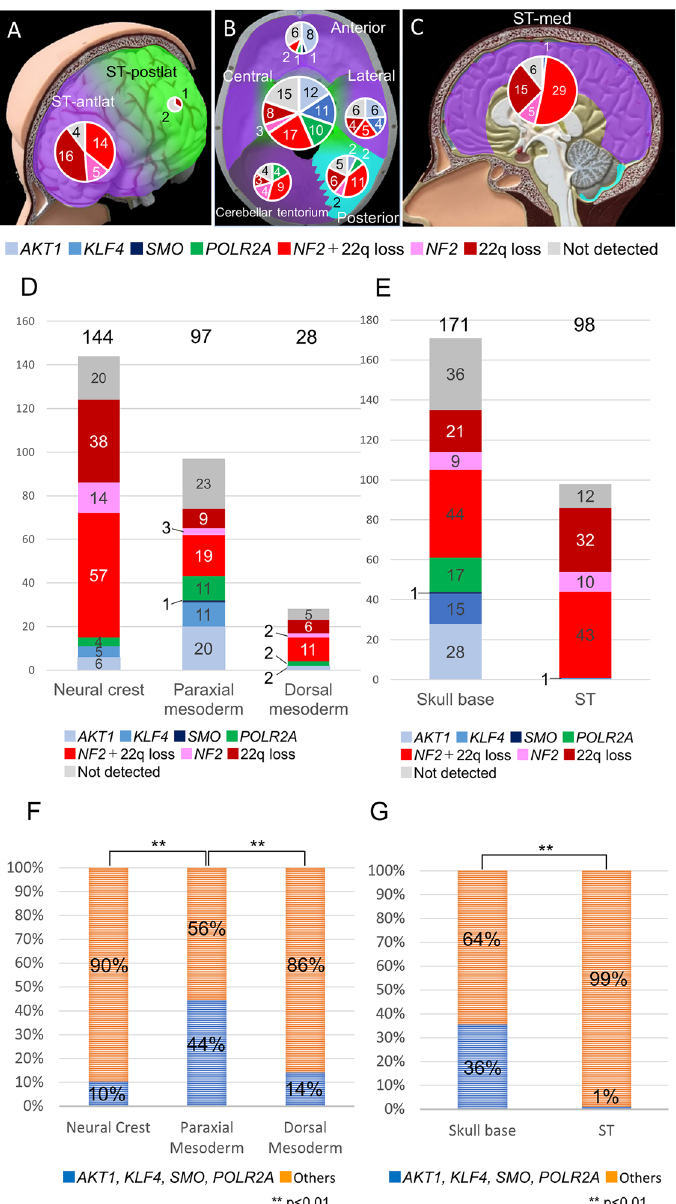
Figure 3. Genetic mutations according to embryologically classified anatomical location of meningiomas. ( A ) Distribution of genetic mutations at ST-ant/lat and ST-post/lat. Each pie chart shows the breakdown of the number of patients harboring each type of mutation. The sizes of the pie charts reflect the total number of the patients with each type of lesion. ( B ) Distribution of mutations in skull-base tumors. The numbers indicate the number of patients harboring tumors at each location. The sizes of the pie chart indicate the total number of patients with tumors at different locations. ( C ) Distribution of mutations at ST-med. The number indicates the number of patients with tumors at each location. The sizes of the pie chart indicate the total number of patients harboring tumors at each location. ( D ) The number of patients harboring mutations at each embryologically classified location. ( E ) The number of patients harboring tumors at the skull base or Supra tentorial area, with mutations. The bar graph shows the numbers of patients with each type of mutation per location. ( F ) Comparison of the ratio of patients harboring AKT1 , KLF4 , SMO , or POLR2A mutations among embryologically classified locations. The ratio of patients harboring AKT1 , KLF4 , SMO , or POLR2A mutations was higher for tumors originating from the paraxial mesoderm location rather than the neural crest or dorsal mesoderm ( p < 0.01, significant on the chi-square test with Bonferroni correction). ( G ) Comparison of the ratio of patients harboring AKT1 , KLF4 , SMO , or POLR2A mutations between skull-base and supra-tentorial tumors. The ratio of patients harboring AKT1 , KLF4 , SMO , or POLR2A mutations was higher for skull-base tumors rather than supra tentorial tumors ( p < 0.01, significant on the chi-square test with Bonferroni correction). ST-ant/lat, supra-tentorial-antero-lateral; ST-post/lat, supra-tentorial-postero-lateral; ST-med, supra-tentorial- medial. Figure generated using Microsoft PowerPoint 2016, https:// www. micro soft.